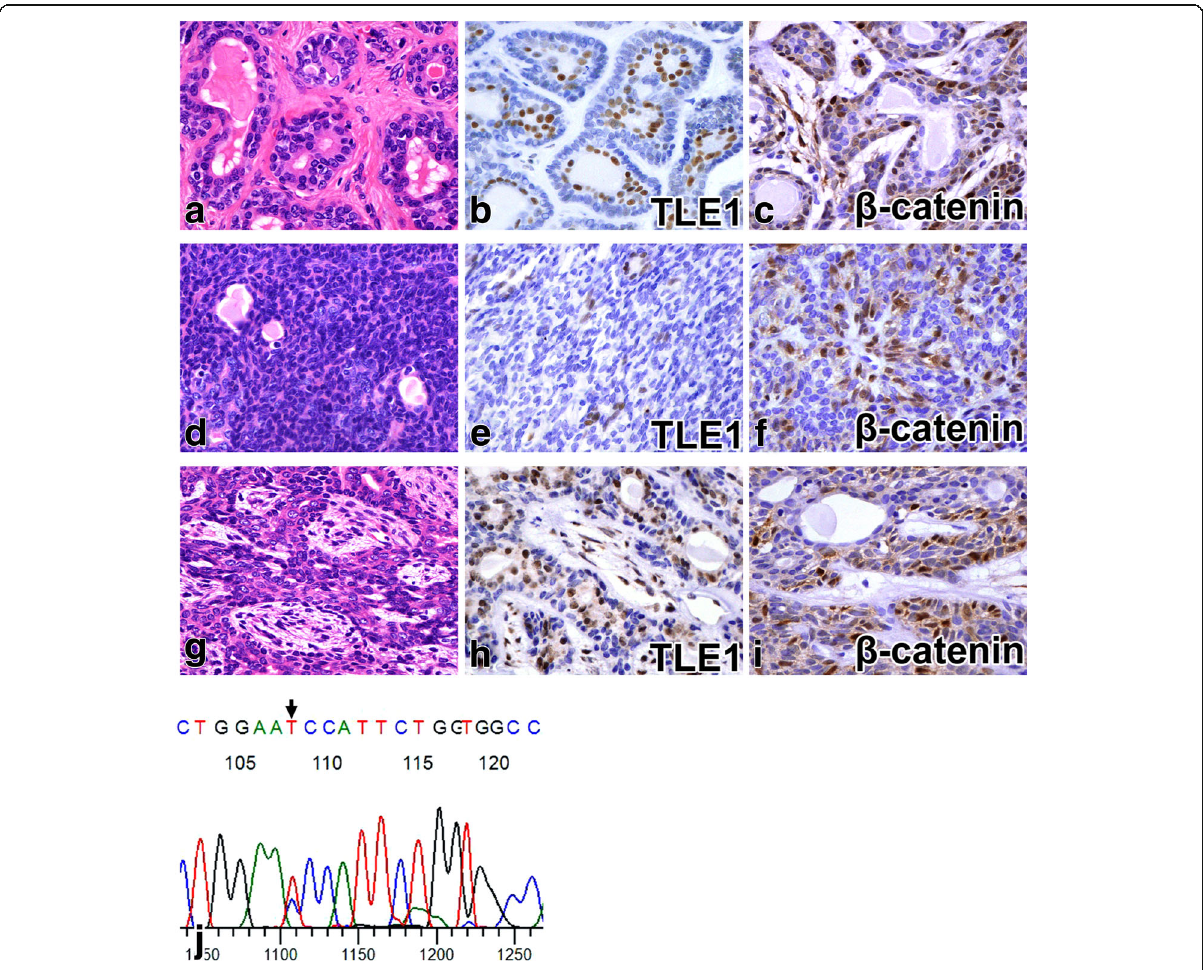
Fig. 2 Basal cell adenoma (BCA). BCA of tubular ( a - c ), solid ( d - f ), trabecular ( g - i ) growth patterns with hematoxylin-eosin staining ( a , d , and g ), TLE1( b , e , and h ), and β -catenin ( c , f , and i ) immunostaining, respectively, are shown. Luminal cells are positive for TLE1 ( b , e , and h ). Abluminal cells are positive for β -catenin ( c , f , and i ) in contrast to staining for TLE1. Mutational analysis for CTNNB1 found an exon 3 mutation in 34% of basal cell adenomas ( j , BCA case